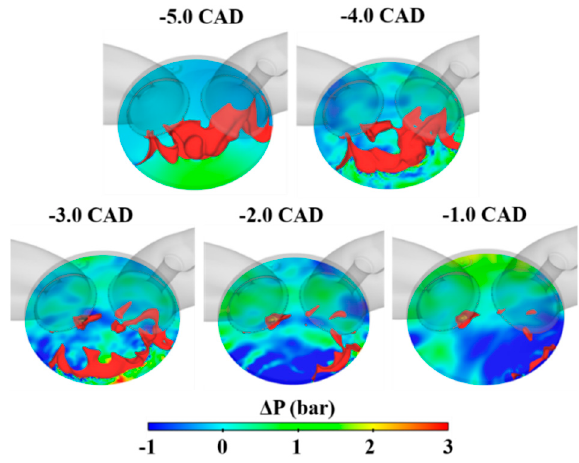
Figure 13. Evolution of 3D in-cylinder combustion process at ω = 0.8.